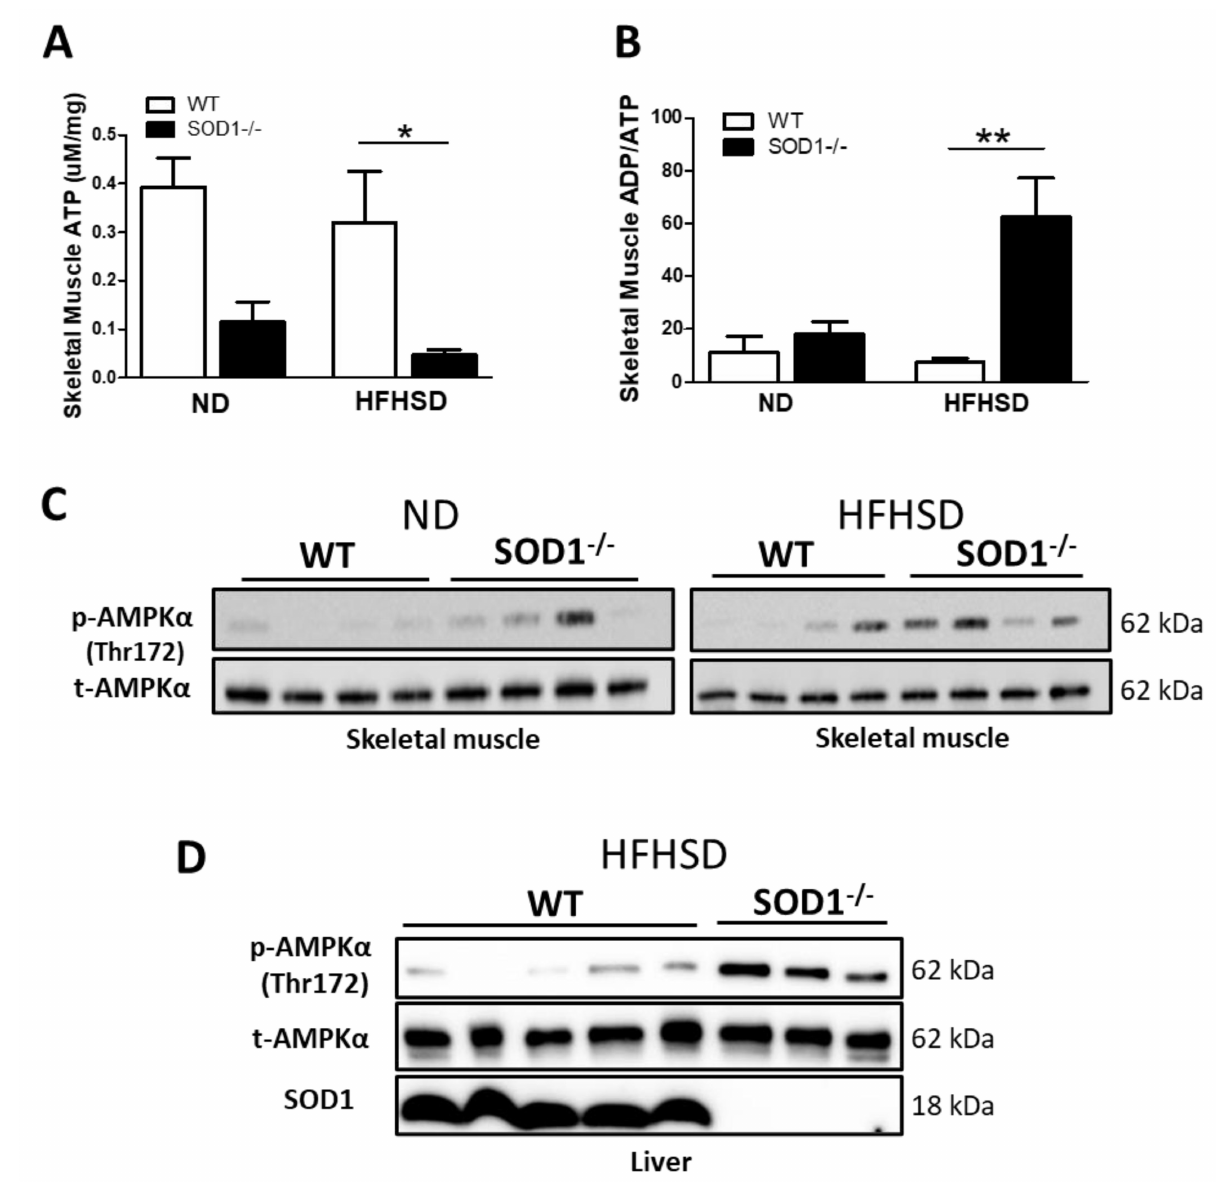
Figure 5. ATP levels and AMPK expression in skeletal muscle. ATP ( A ) and ADP/ATP ratio ( B ) of the skeletal muscle. (WT on ND; n = 8, SOD1 − / − on ND; n = 4, WT on HFHSD; n = 8, SOD1 − / − on HFHSD; n = 9). ( C ). Western blotting of skeletal muscle. ( D ). Western blotting of liver. Error bars represent SEM. * p < 0.05, ** p < 0.01. WT: wild-type mice, SOD1 − / − : SOD1 deficient mice, ND: normal diet, HFHSD: high-fat/high-sucrose